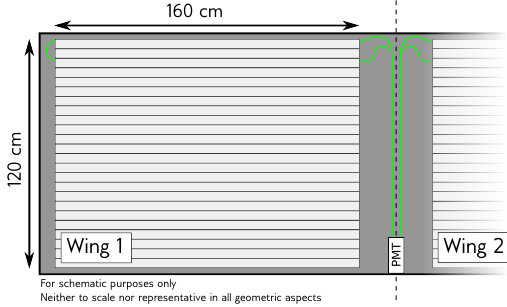
Figure 1. Top-down schematic depiction of the arrangement of bars and fibers within the SSD casing. The written dimensions describe the active surfaces of the detectors, namely the scintil- lator bars.